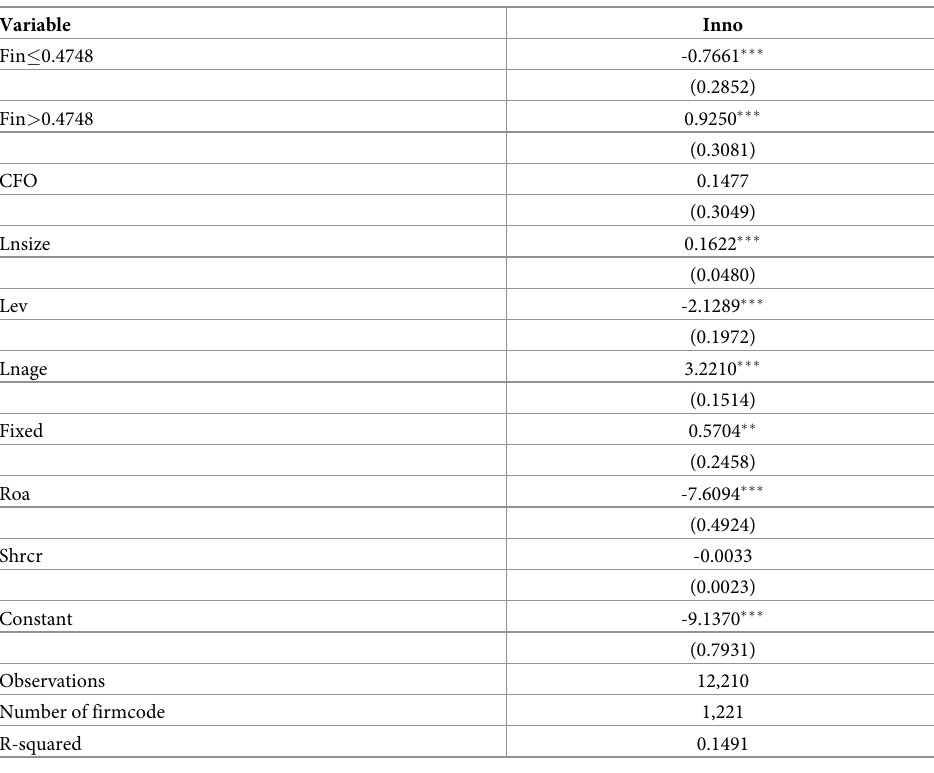
Table 4. Regression results of threshold